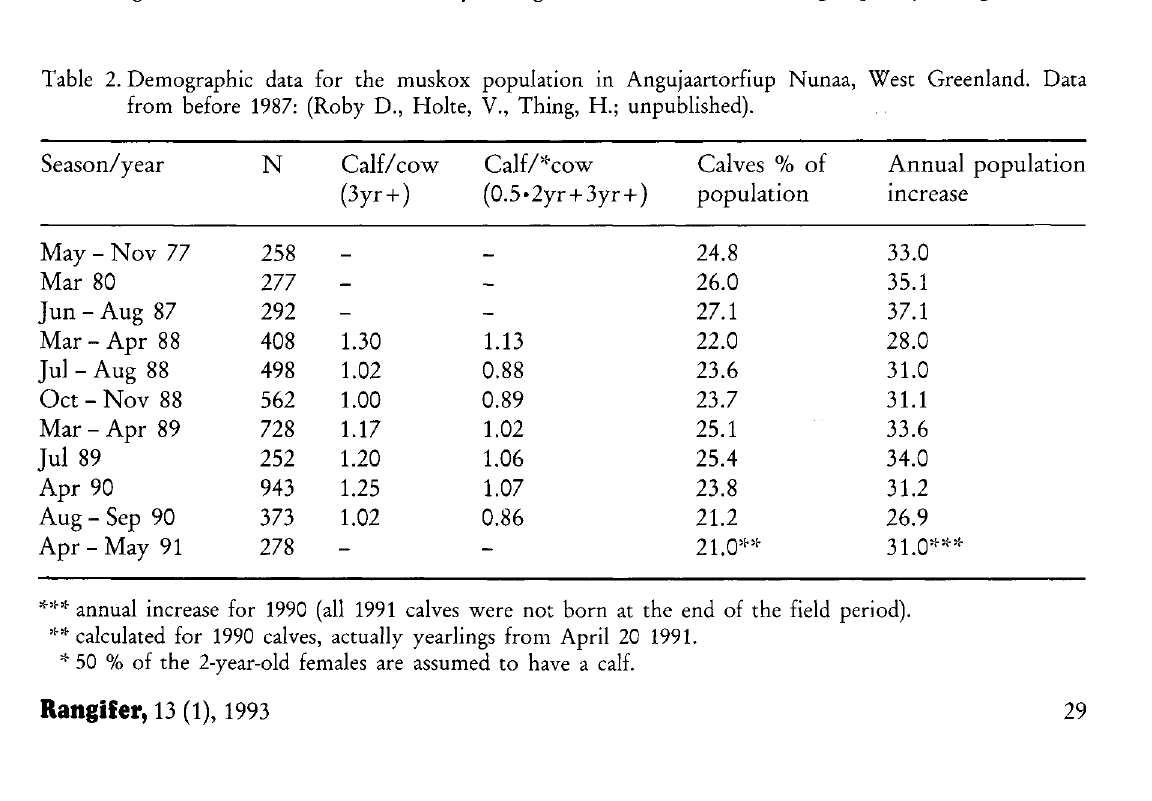
Table 2. Demographic data for the muskox population in Angujaartorfiup Nunaa, West Greenland. Data from before 1987: (Roby D., Holte, V., Thing, H .;